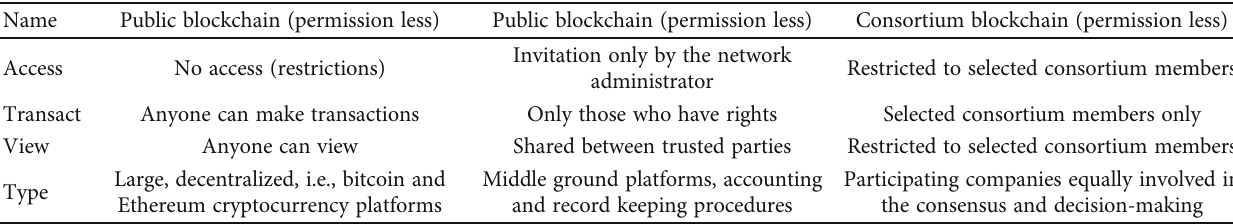
Table 1: Types of